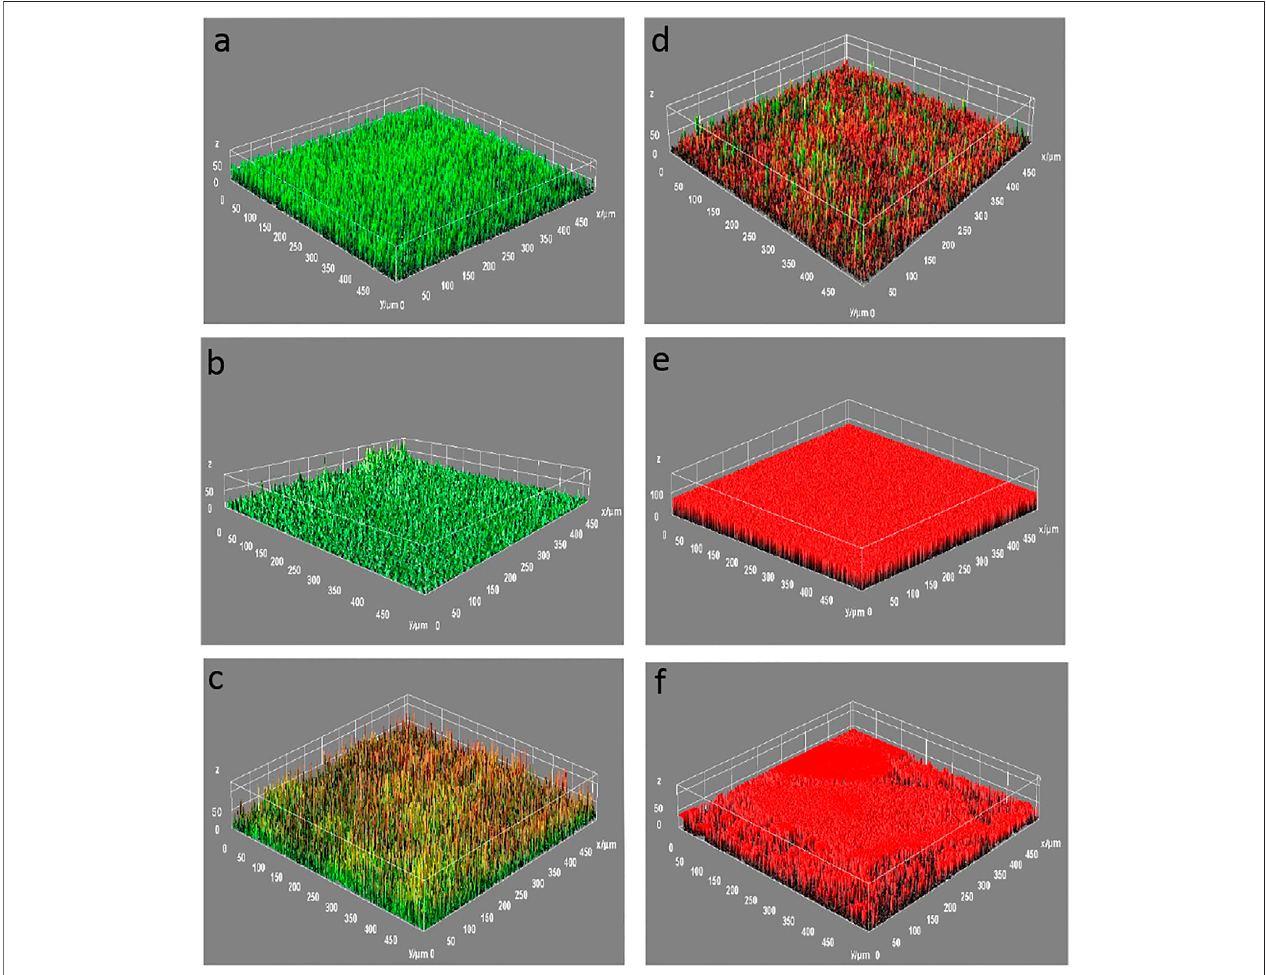
FIGURE5| CLSMimagesofbio fi lmsgrownfor (A) 24 h, (B) 96 h,and (C) 10 daysfortheWEPcoating(control)and (D) 24 h, (E) 96 h,and (F) 10 daysforGOWE- 0.1 coating. The coating was stained with SYTO9 and PI prior to microscopic observation. The red color corresponds to dead bacterial cells and the green color corresponds to living bacterial cells. The scale is in